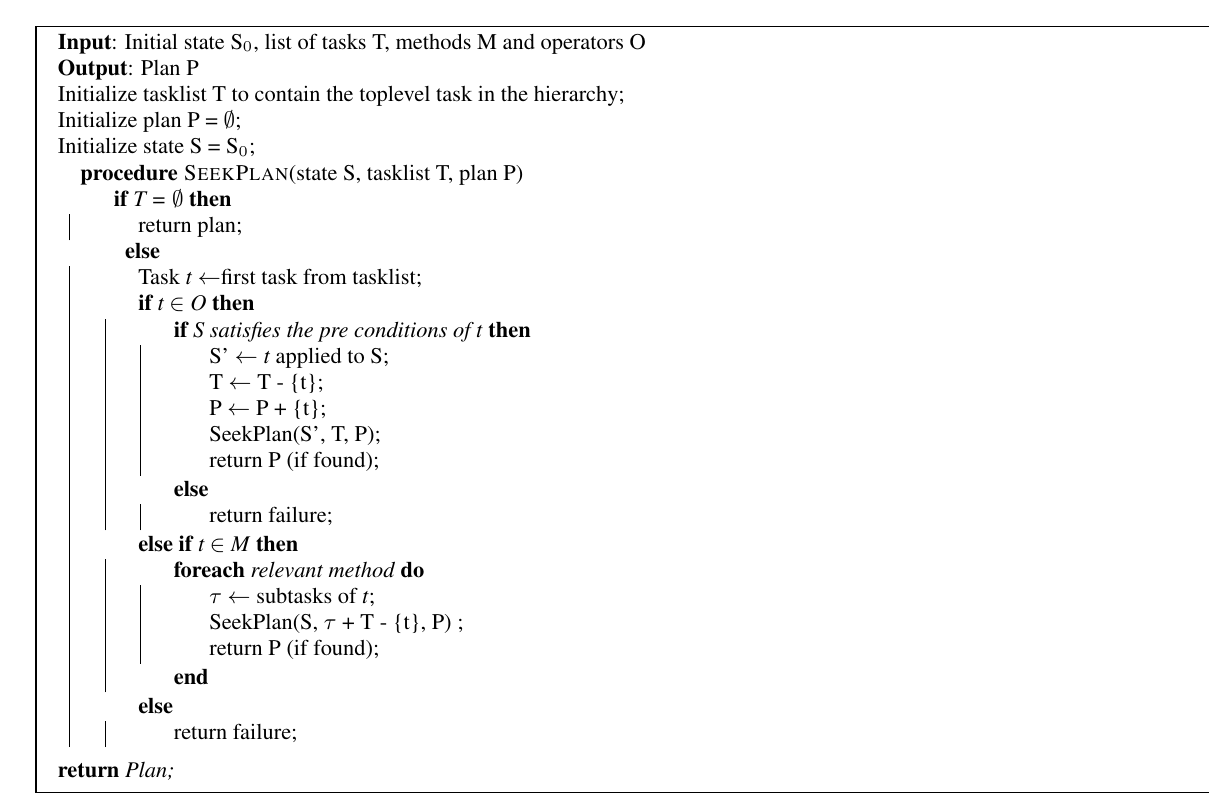
Algorithm 1: HTN Planning